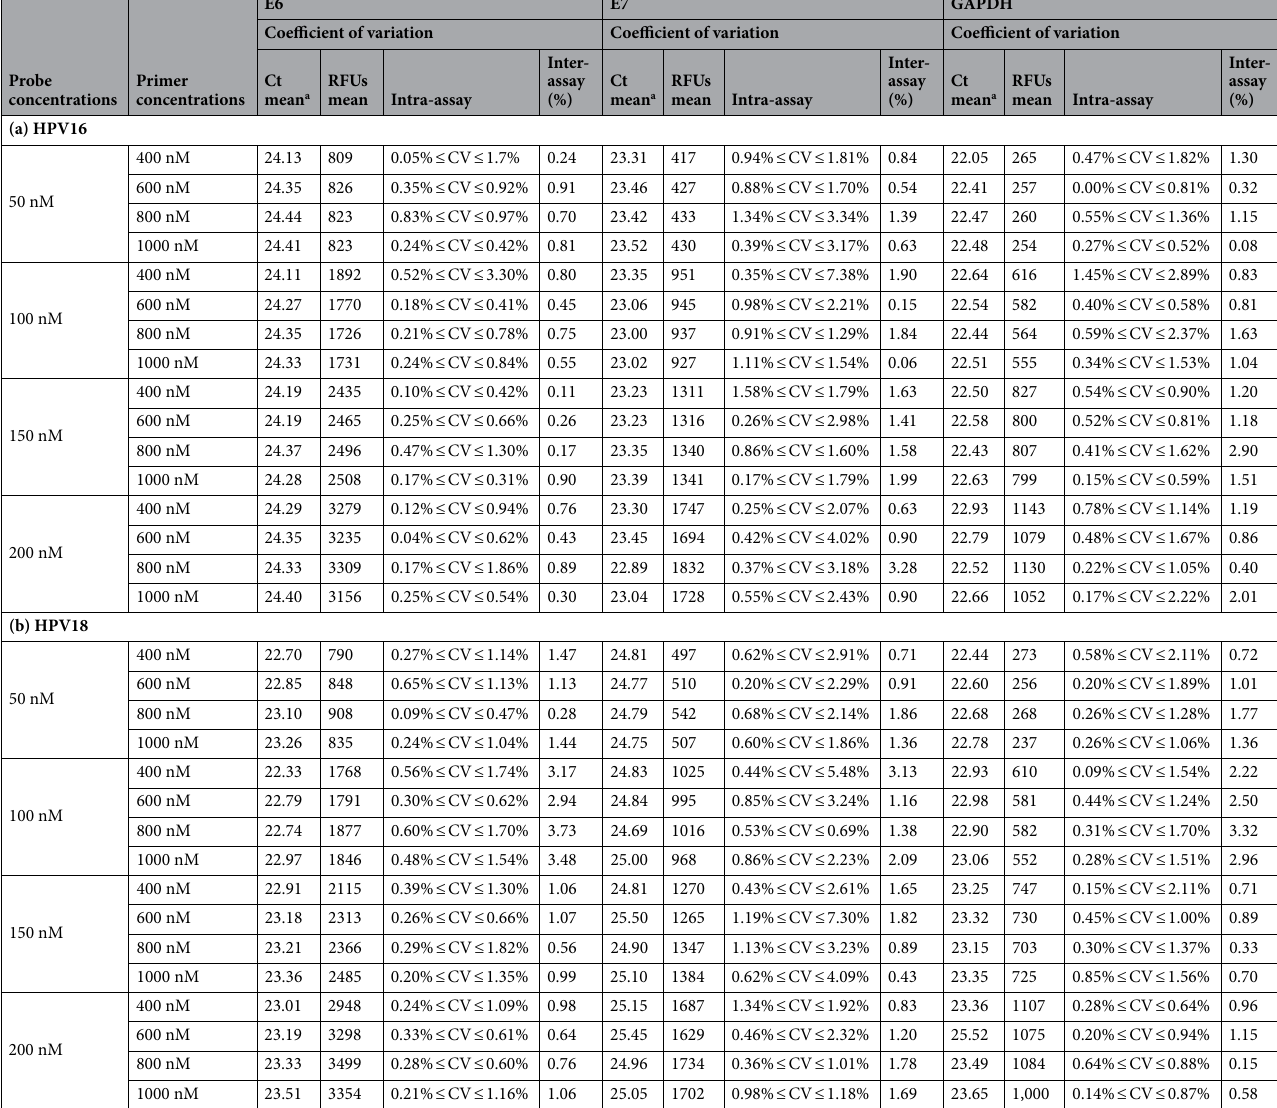
Table 2. Intra- and inter-assay reproducibility of HPV16 (a) and HPV18 (b) qPCR multiplexes for selected primer and probe concentrations. Ct cycle threshold. a Mean of inter-assay Ct from technical